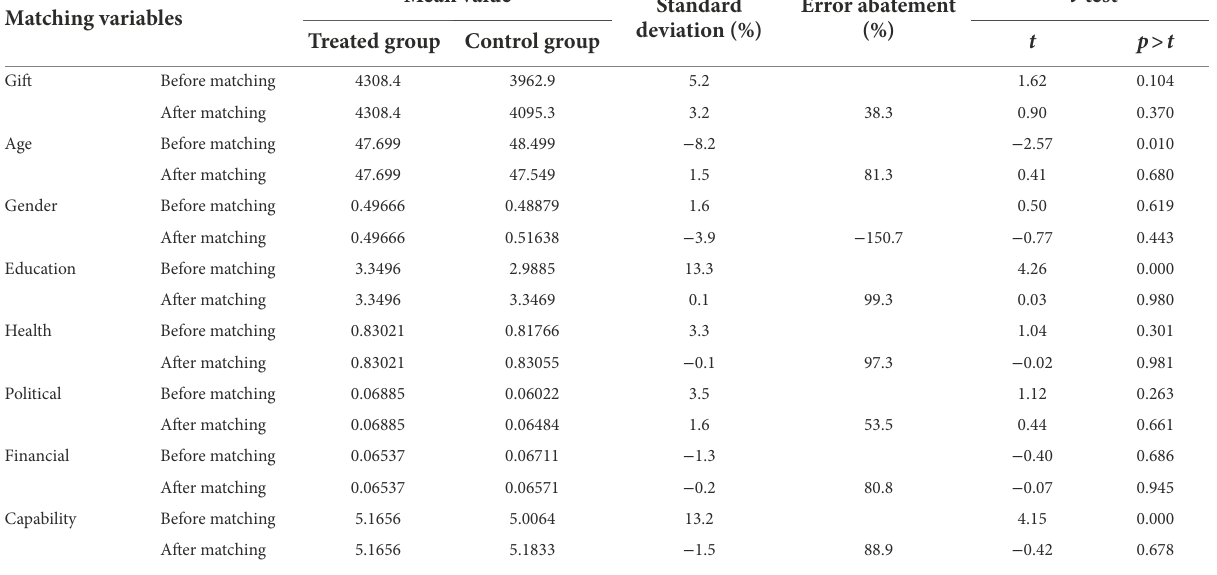
TABLE 4 Sample matching variables and balance test.